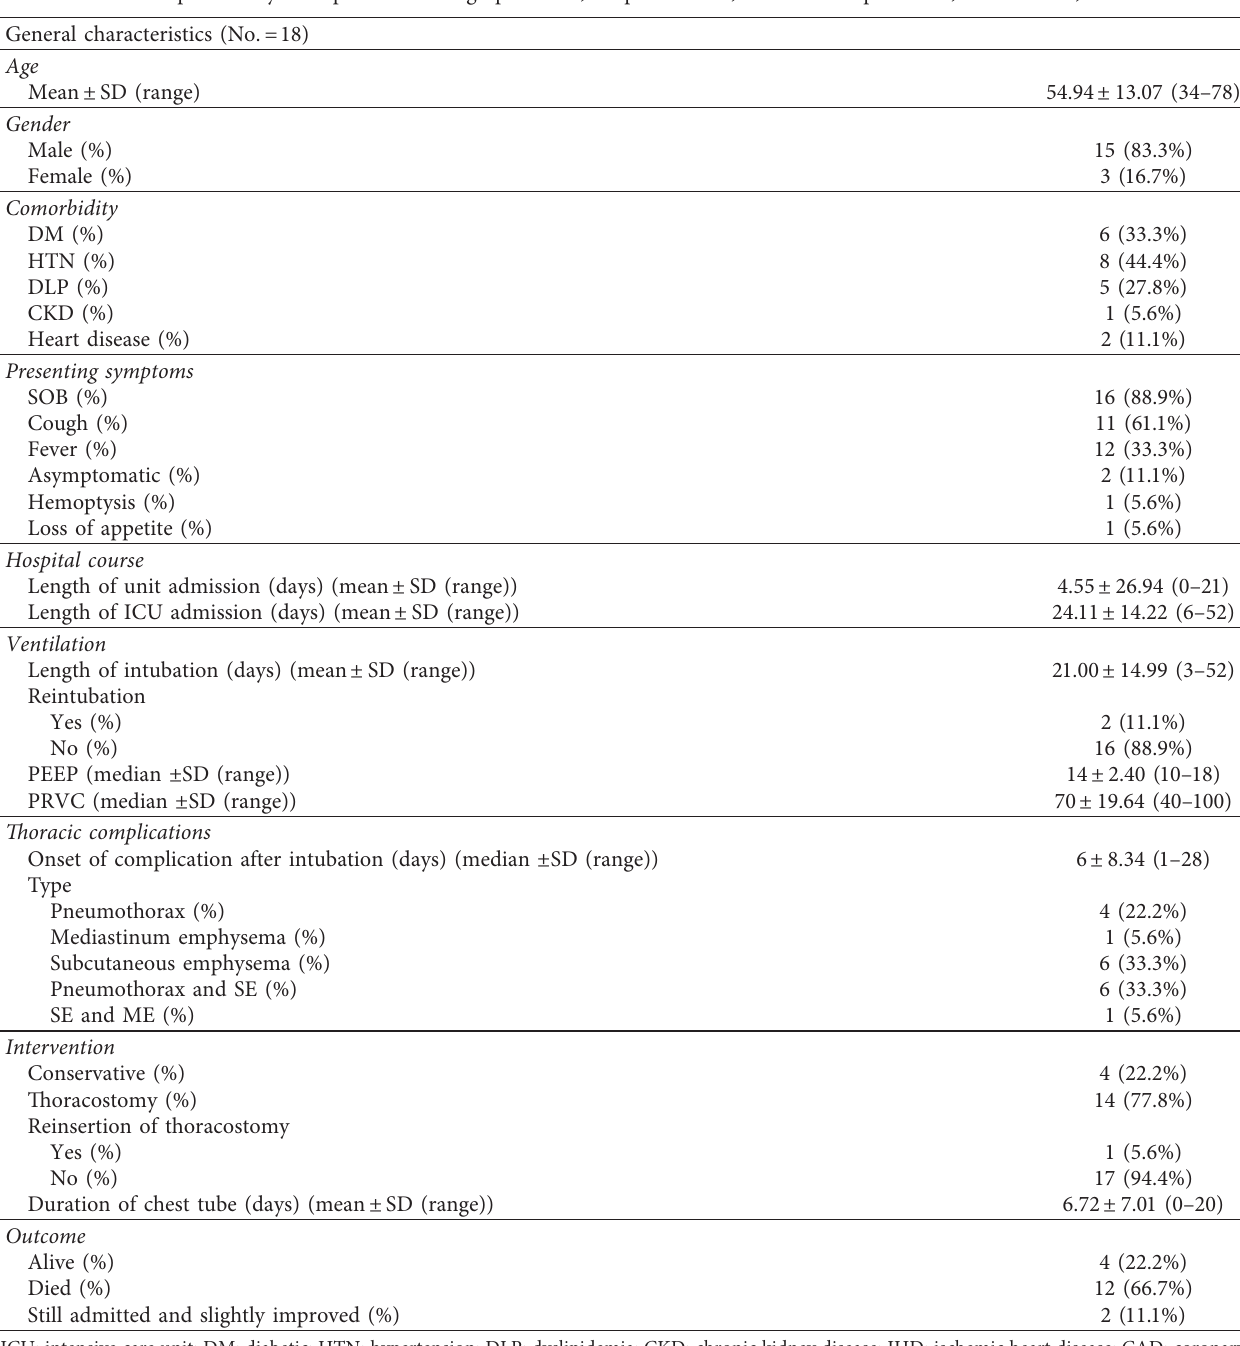
Table 1: Descriptive analysis of patients' demographic data, hospital course, thoracic complications, intervention, and outcome. General characteristics (No. �